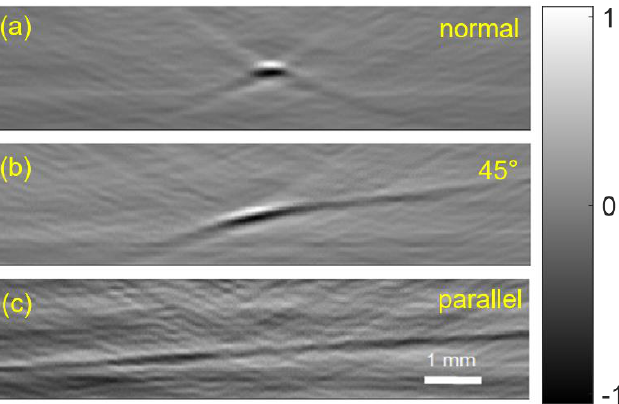
Figure 7. Optoacoustic reconstruction of a copper wire at three different section angles.